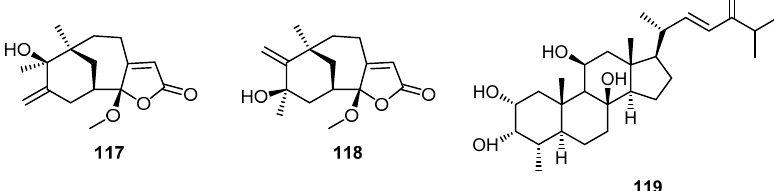
Figure 28. Chemical structures of hyrtiosenolide A ( 117 ), hyrtiosenolide B ( 118 ) and hyrtiosterol ( 119 ). A trichlorinated metabolite, poipuol ( 120 ), was isolated from an undescribed marine sponge